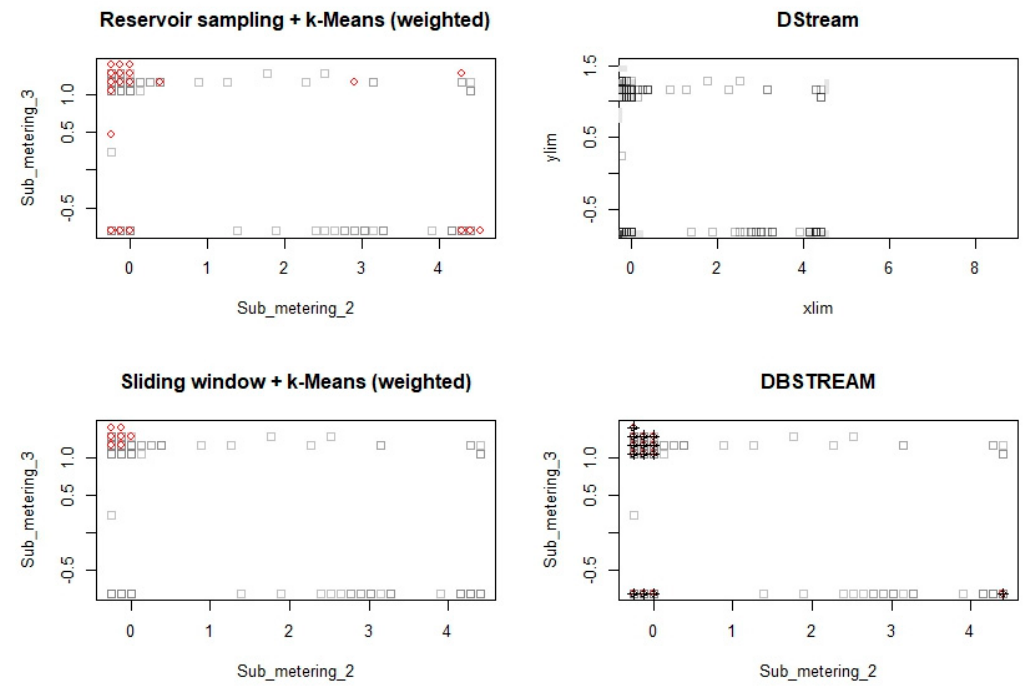
Figure 8. micro-cluster assignment area for different data stream clustering algorithms (using real data stream).